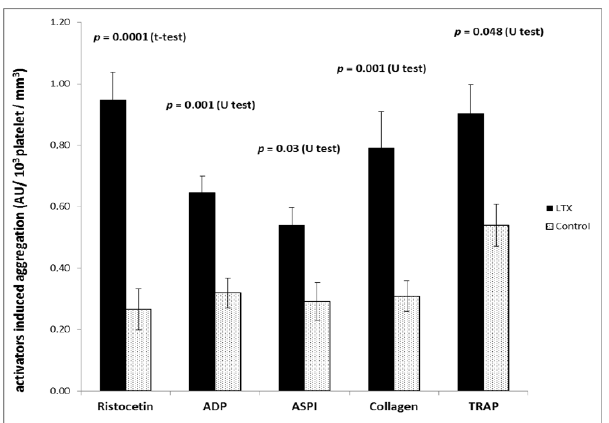
Figure 5. Platelet function ratio (correction for platelet count) in liver transplantation patients ( n = 35) and control patients ( n = 10). Platelet aggregation was induced by ristocetin, ADP, arachidonic acid (ASPI), collagen, and thrombim receptor-activating peptide (TRAP) at the begining of the procedure. Data are given as mean and SEM.